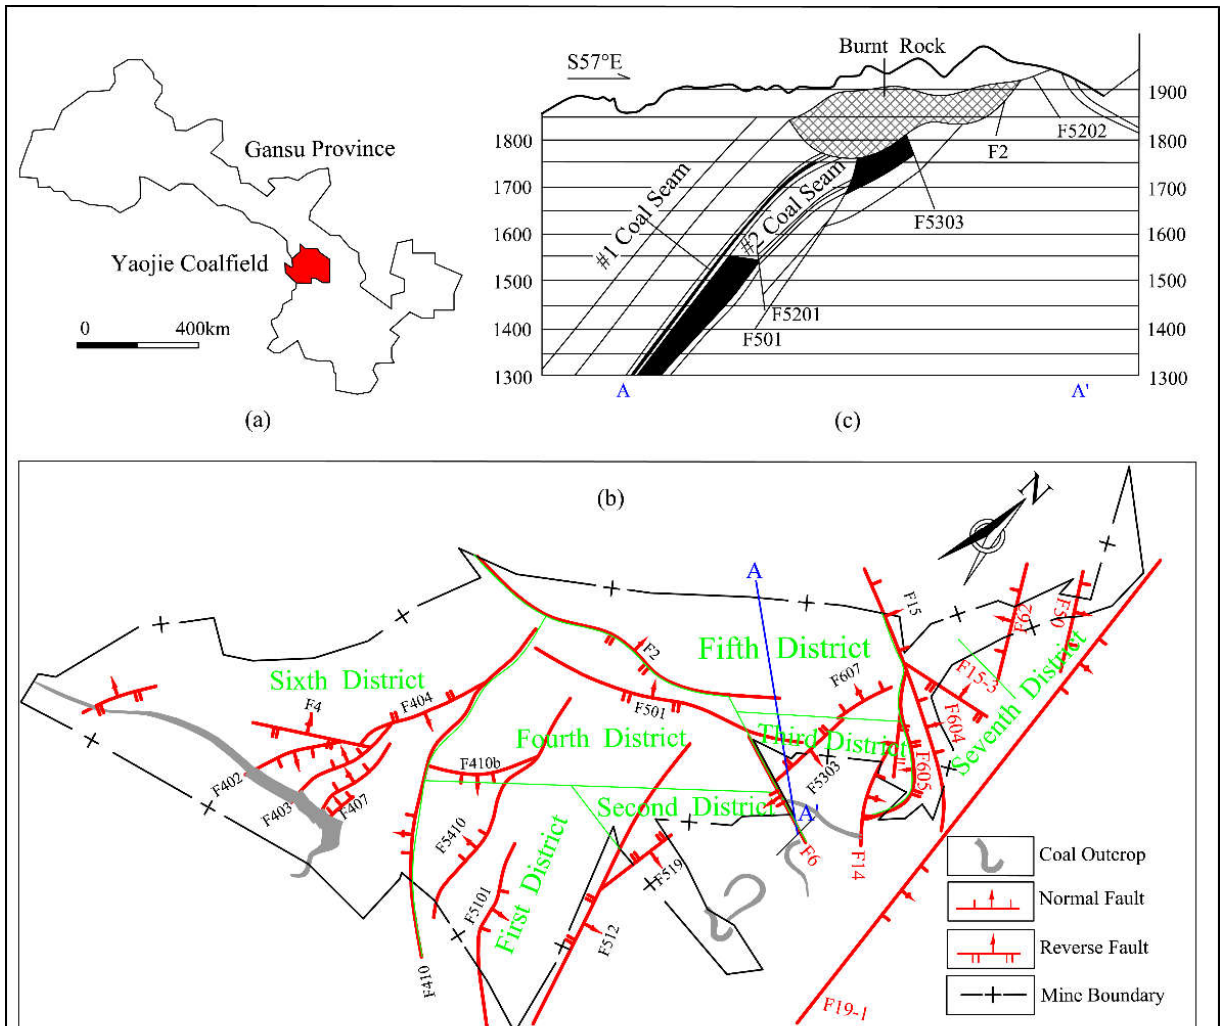
Figure 1. The location and the geological setting of the Yaojie No.3 coal mine: ( a ) location of the Yaojie coalfield; ( b ) geological setting of the Yaojie No.3 coal mine and ( c ) schematic cross section along the line A-A’ in ( b ).